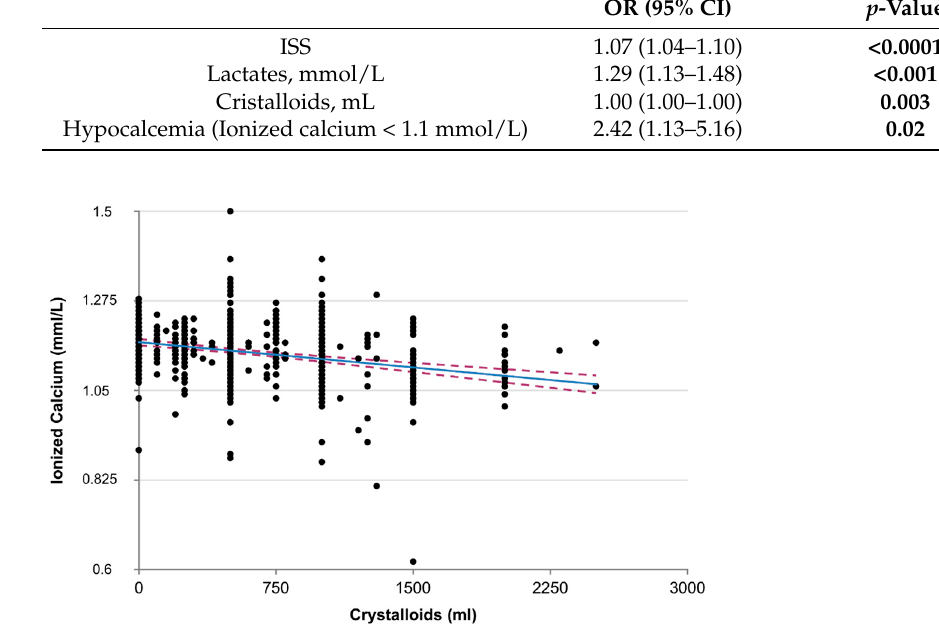
Figure 2. Linear regression: crystalloids infusions vs. ionized calcium. (R = 0.25, R 2 = 0.065, p < 0.001). Table 4. Independent association with hypocalcemia (logistic multivariate analysis) (bold: